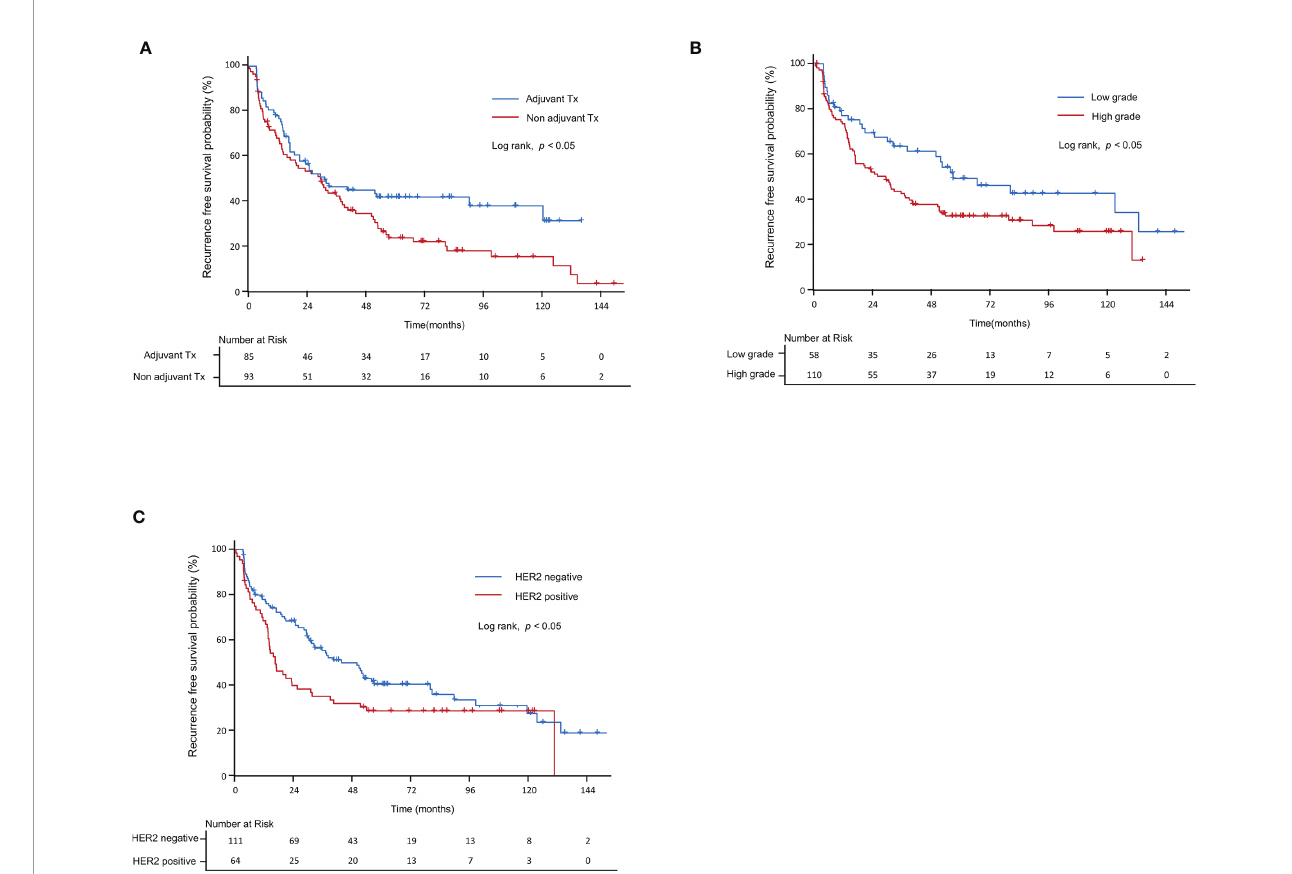
FIGURE 5 | Kaplan – Meier curve for recurrence-free survival in non-muscle-invasive bladder cancer patients. Recurrence-free survival according to (A) grade, (B) adjuvant therapy, and (C) HER2+. HER2, human epidermal growth factor